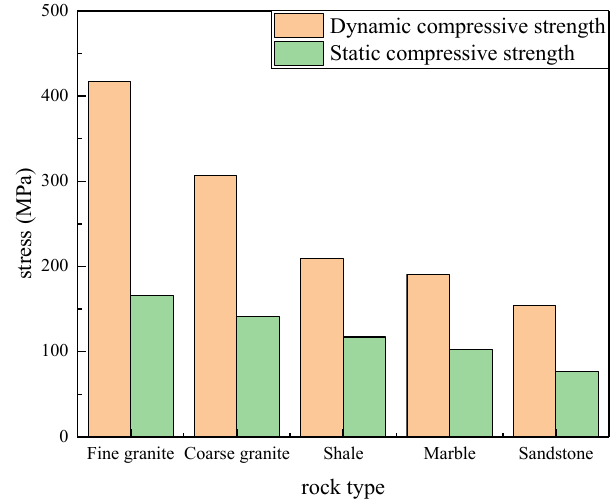
Figure 3. Change in compressive strength of rock samples.